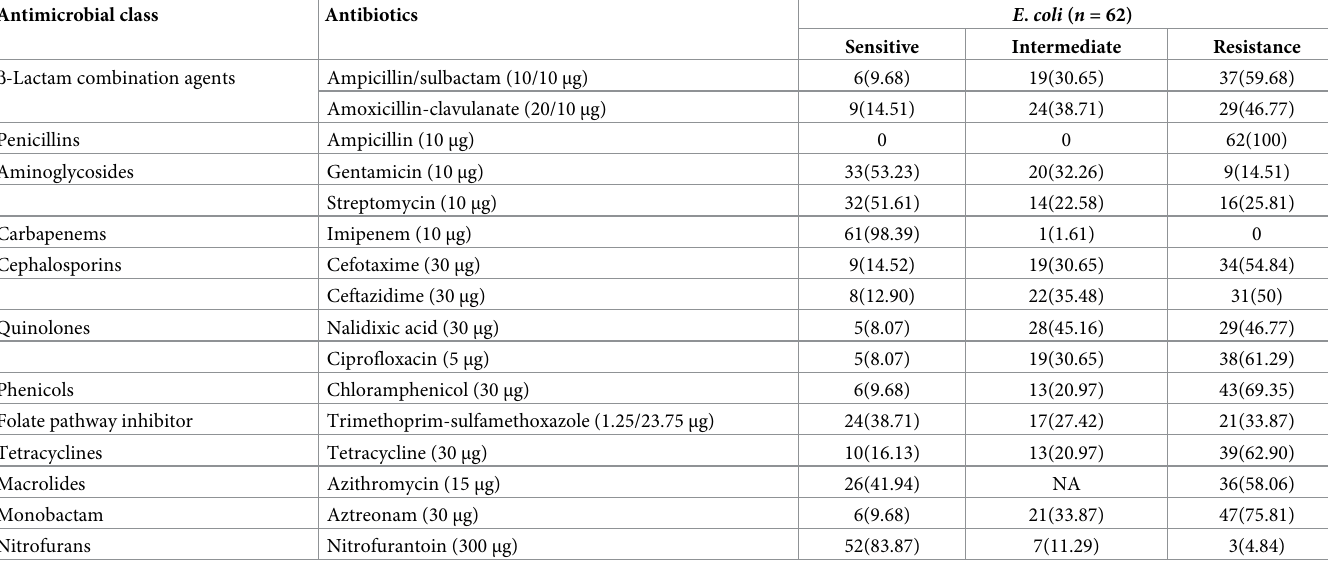
Table 2. Antimicrobial susceptibility profile of the E . coli isolates.